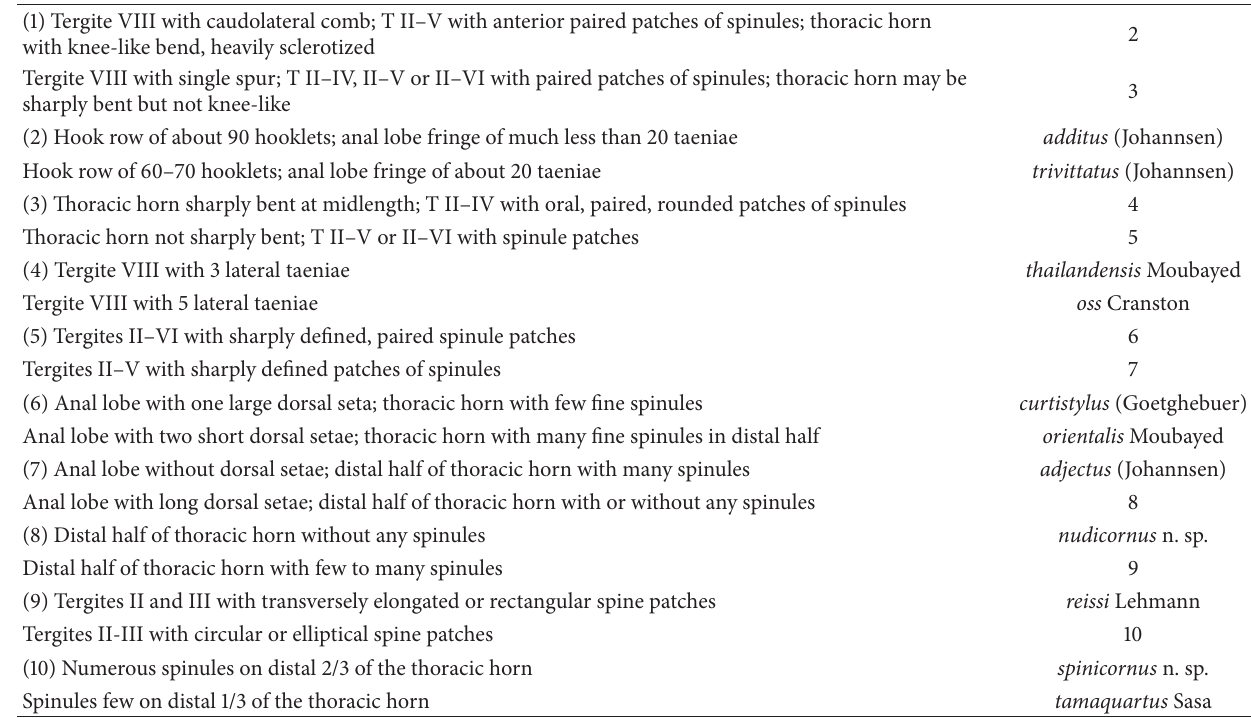
Table 5: Key to Pupae of Oriental Rheotanytarsus Thienemann & Bause (Modified after Kyerematen et al.